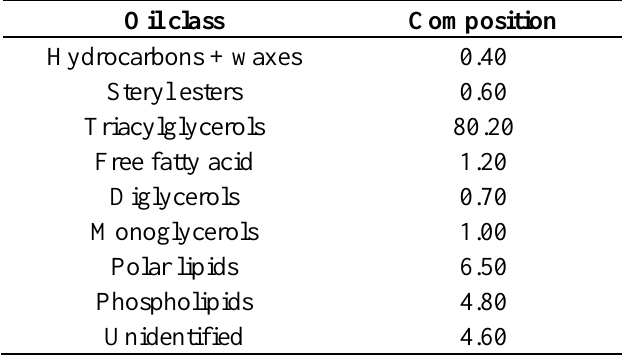
Table 5. Percent composition of I. hederacea seed